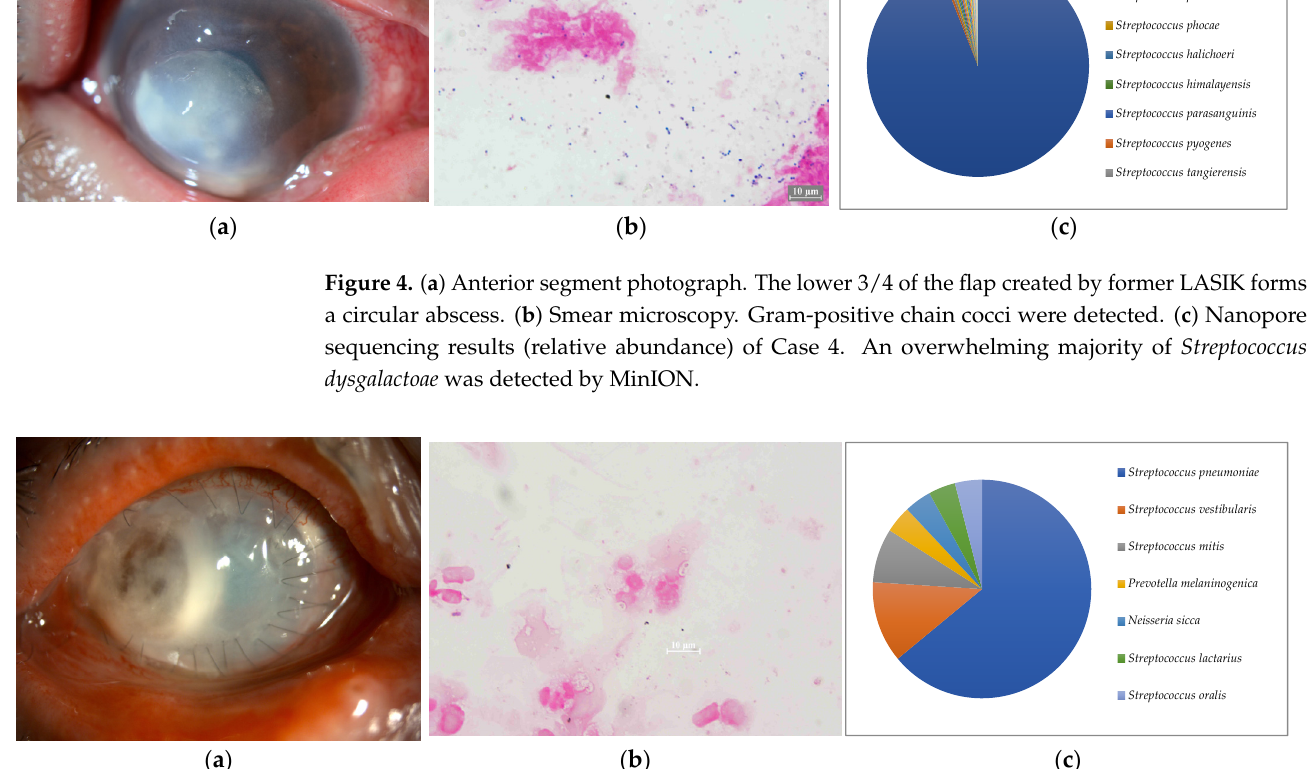
Figure 5. ( a ) Anterior segment photograph. The entire corneal graft was opaque, with abscess and infiltration, and temporal corneal graft showed melting. ( b ) Smear microscopy. Diplococci that appear Gram-negative were determined primarily due to heterogeneous staining but were found to be encapsulated Gram-positive. ( c ) Nanopore sequencing results (relative abundance) of Case 5. An overwhelming majority of Streptococcus pneumoniae was detected by MinION.